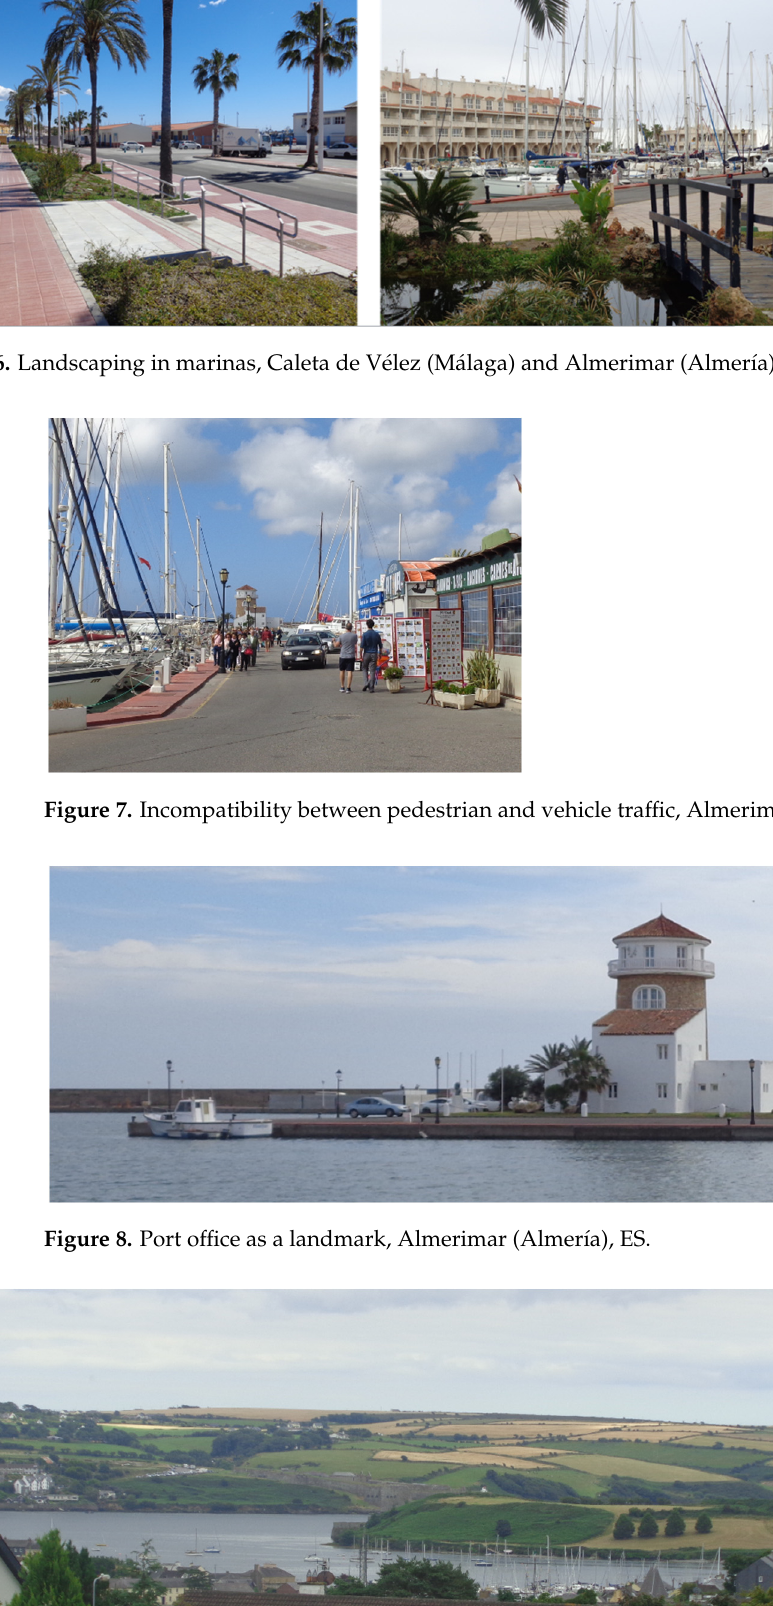
Figure 7. Landscaping in marinas, Caleta de Vélez (Málaga) and Almerimar (Almería), ES.